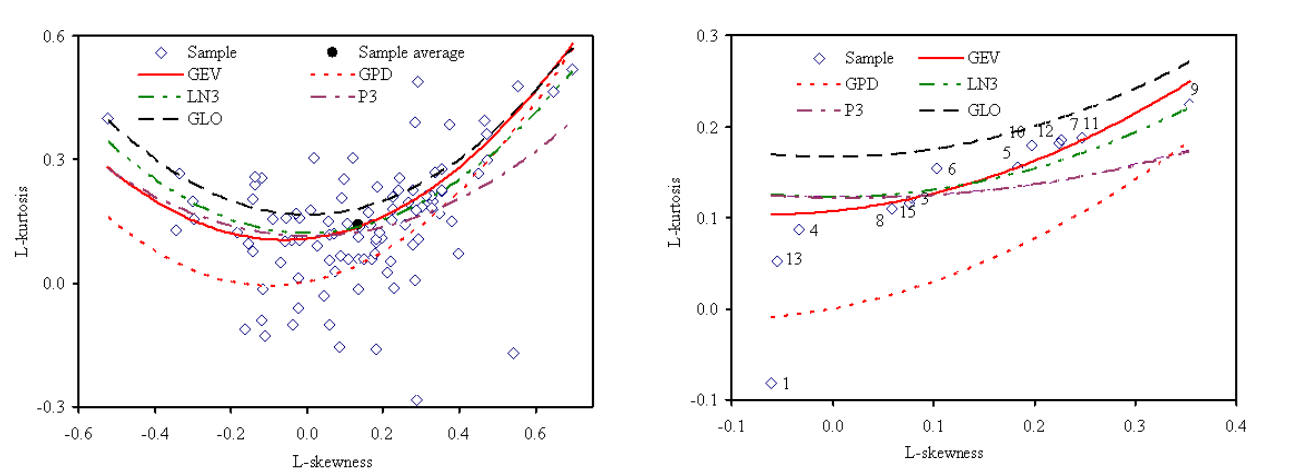
Fig. 5. L -moment ratio diagram for the at-site AMF data in the River Nile basin.